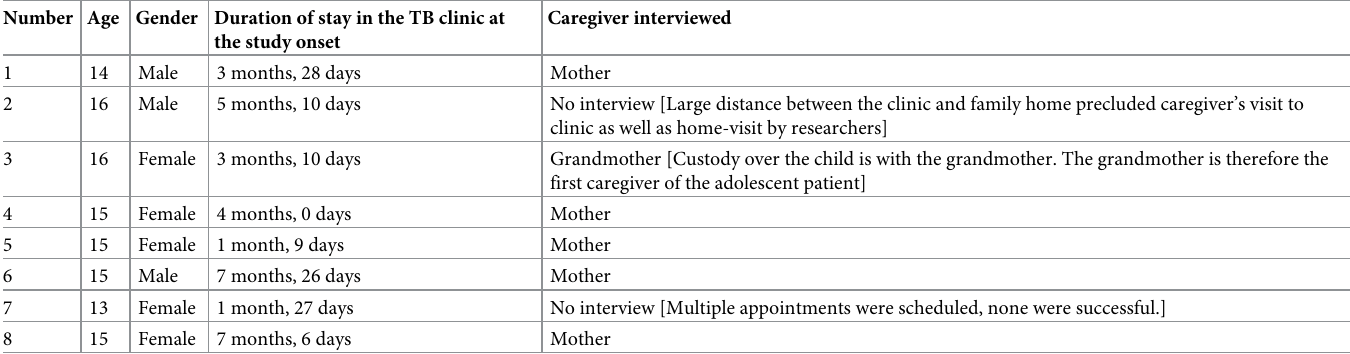
Table 1. Adolescents and their